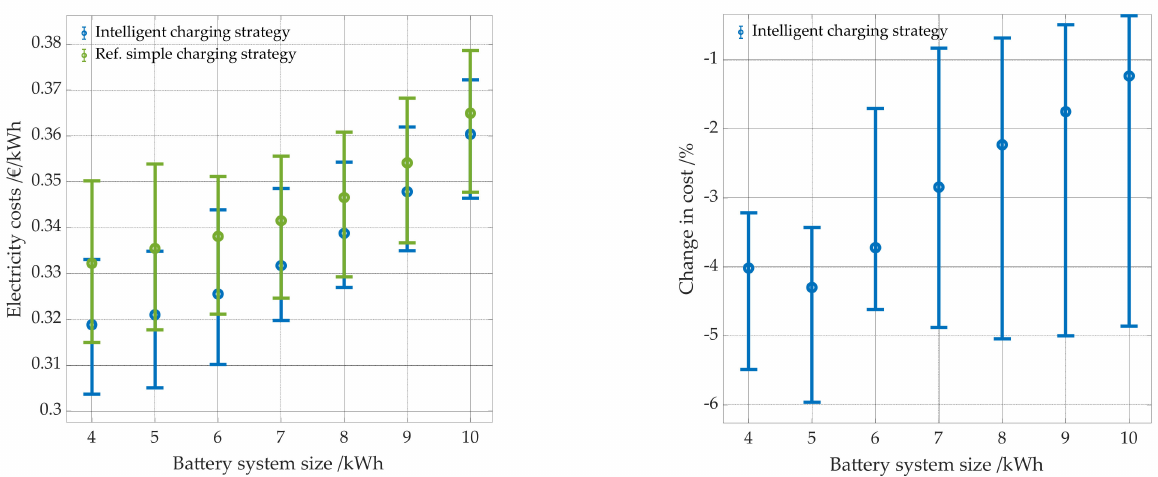
Figure 26. Electricity costs per kWh as a function of battery system size ( left panel) and the change in cost as a function of battery size ( right panel). Shown are the results for a and an intelligent charging strategy to prevent calendar aging. The reference case is shown in